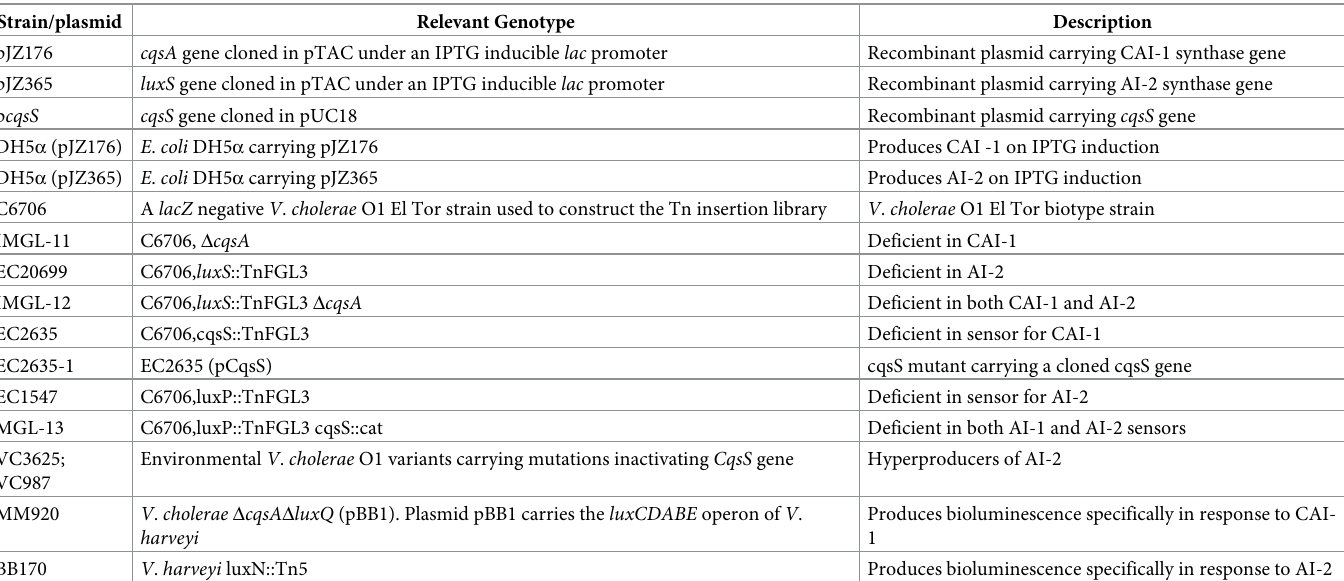
Table 1. Description of bacterial strains and plasmids included in this study.